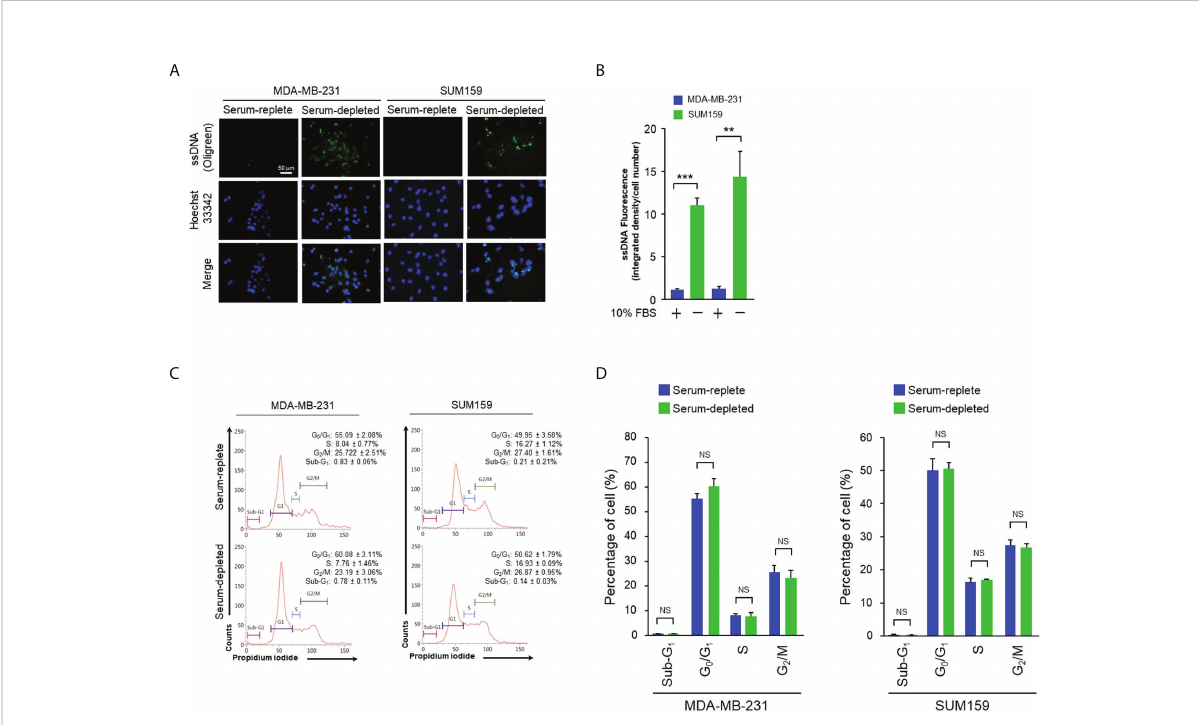
FIGURE 1 Serum depletion induced cytosolic ssDNA accumulation in TNBC cells. (A) , MDA-MB-231 and SUM159 cells were cultured in normal or serum- depleted media for 24 hr. The production of ssDNA expression was detected by OliGreen staining. The nuclei were counterstained with Hoechst 33342. Fluorescent images were captured at 400x magni fi cation. Bar, 50 m m. (B) , The images in (A) were quantitated and plotted. The data of three independent results are shown as means ± SD (standard deviation) and the statistical signi fi cance was calculated by Student ’ s t- test. **, p < 0.01; ***, p < 0.001. C, The indicated cells were cultured as described in (A) for 24 hr, fi xed, and stained with propidium iodide. Cell cycle pro fi les were analyzed by fl ow cytometry. The proportions of cells in sub-G 1 , G 0 /G 1 , S and G 2 /M were indicated with corresponding standard deviation. (D) , The results of three independent biological repeats of cell cycle pro fi ling as described in (C) were plotted with means ± SD. Statistical signi fi cance was calculated by Student ’ s test. NS, non-signi fi cant with the p values greater than